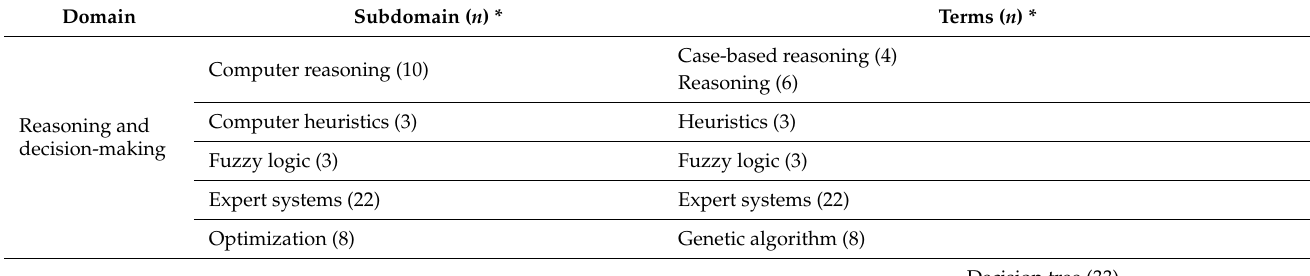
Table 5. AI technology applications in